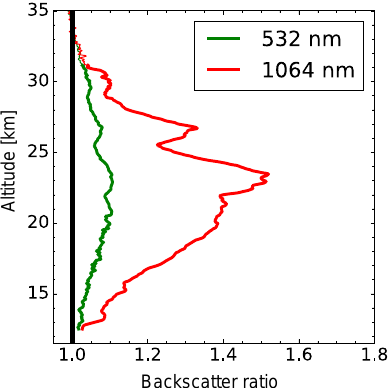
Figure 13. Altitude profiles of backscatter ratios β for laser wave- lengths of 532nm (green line) and 1024nm (red line). β is the ratio of the total signal relative to the intensity expected from molecular scattering only. β > 1 indicates the presence of